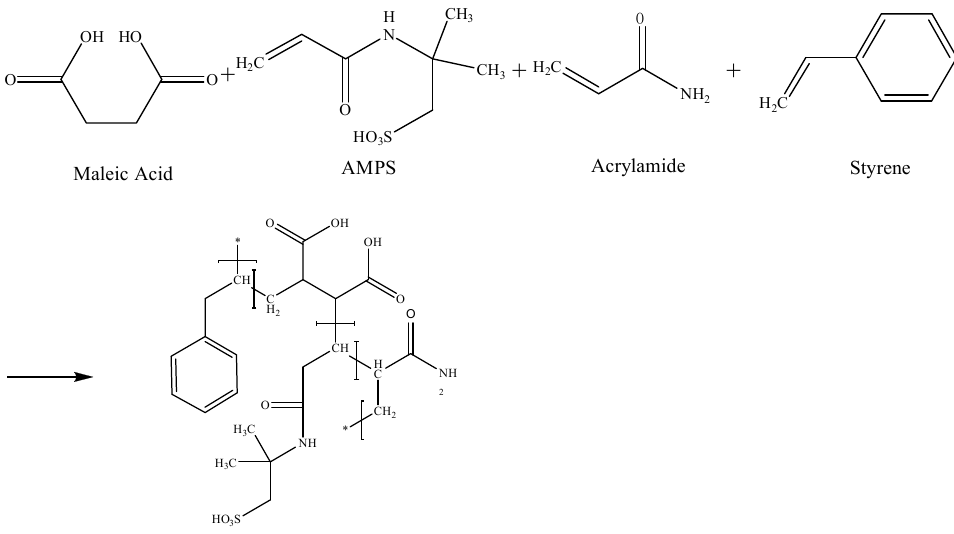
Figure 1. Schematic of Acrylamide/2-Acrylamide-2-methylpropanesulfonic Acid/Styrene/Maleic anhydride polymer (PAASM) synthesis.